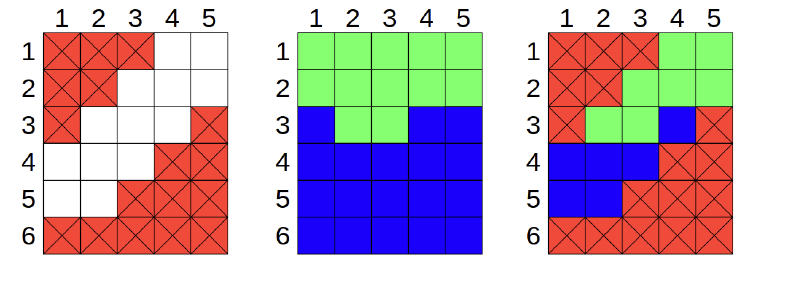
Figure 1. ( Left ) representation of the realistic space, where the white squares are the realistic states for a dataset and the red crossed squares are the unrealistic entries. ( Middle ) representation of model’s output for all values, as models are just mathematical formulations, any input will lead to an output (even the unrealistic dataset points), the green and blue squares represent two different model output classifications. ( Right ) superposition of the two first, where it shows the realistic values to a